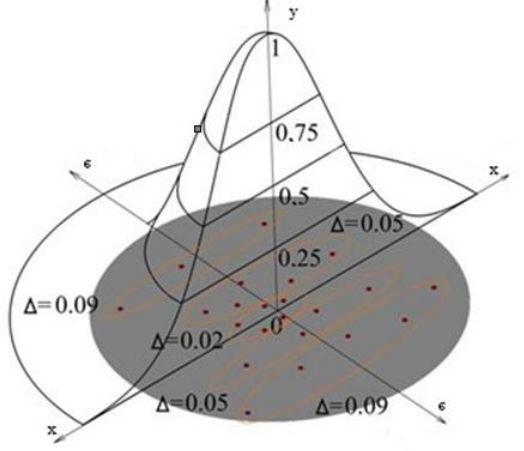
Figure 11. Distribution of the random value of deviations у = θ ( u ), where х = u = (x i − ξ)/(ξ·σ), with center ξ and dispersion σ 2 .